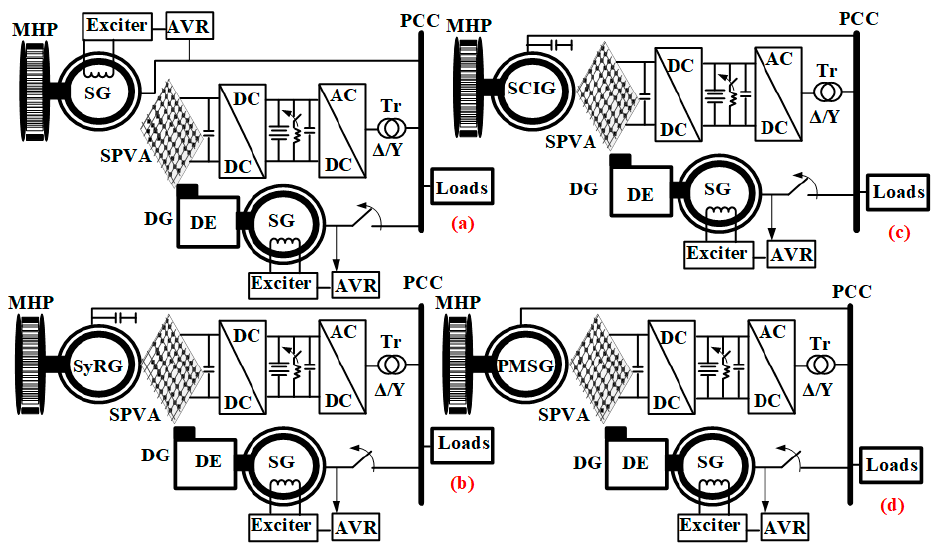
Figure 6. Off-grid configurations having SPVA, MHP, DE driven SG, and MHP driven: ( a ) SG, ( b ) SyRG, ( c ) SCIG, and ( d ) PMSG.